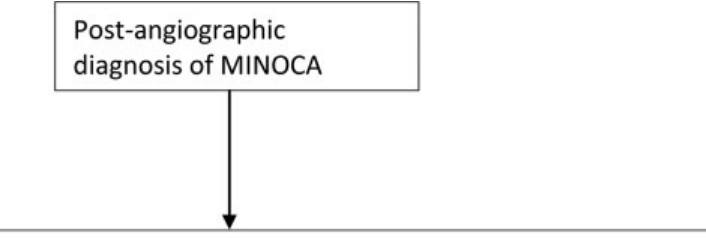
TH Open Vol. 5 No. 2/2021 © 2021. The